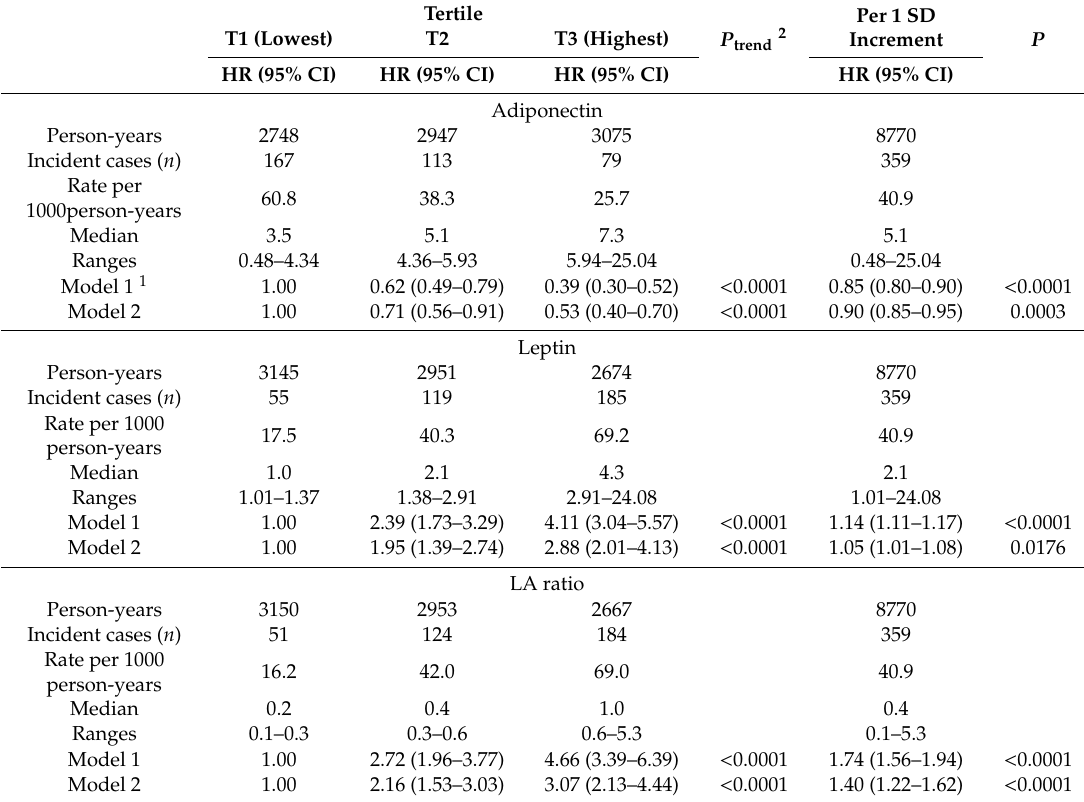
Table 2. Adjusted hazard ratios (with 95% confidence intervals) for metabolic syndrome according to baseline serum adiponectin, leptin levels, and leptin-adiponectin ratio in Korean men aged 45–76 years.